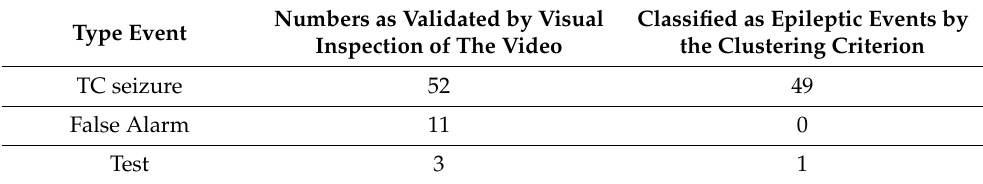
Table 1. Comparison between visual and automated event validation. We selected a session with 66 detected events. Visual review of the recorded video fragments revealed 52 TC seizures of the patient, 11 false alarms related to the condition of the patient but not TC seizures and three test events where the caregivers were testing another detection device working in parallel with the camera detection. The numbers are in the second column. The third column gives the classification according to the automated clustering algorithm. The numbers present the events classified as epileptic seizures. From the 52 validated seizures, 49 are correctly classified. The rest of the three are therefore false negative classifications. All the false alarms were outside the cluster criterion and therefore labeled correctly. From the three test events, one was interpreted by the system as a TC seizure, and the other two were outside the cluster and labeled as false positives.